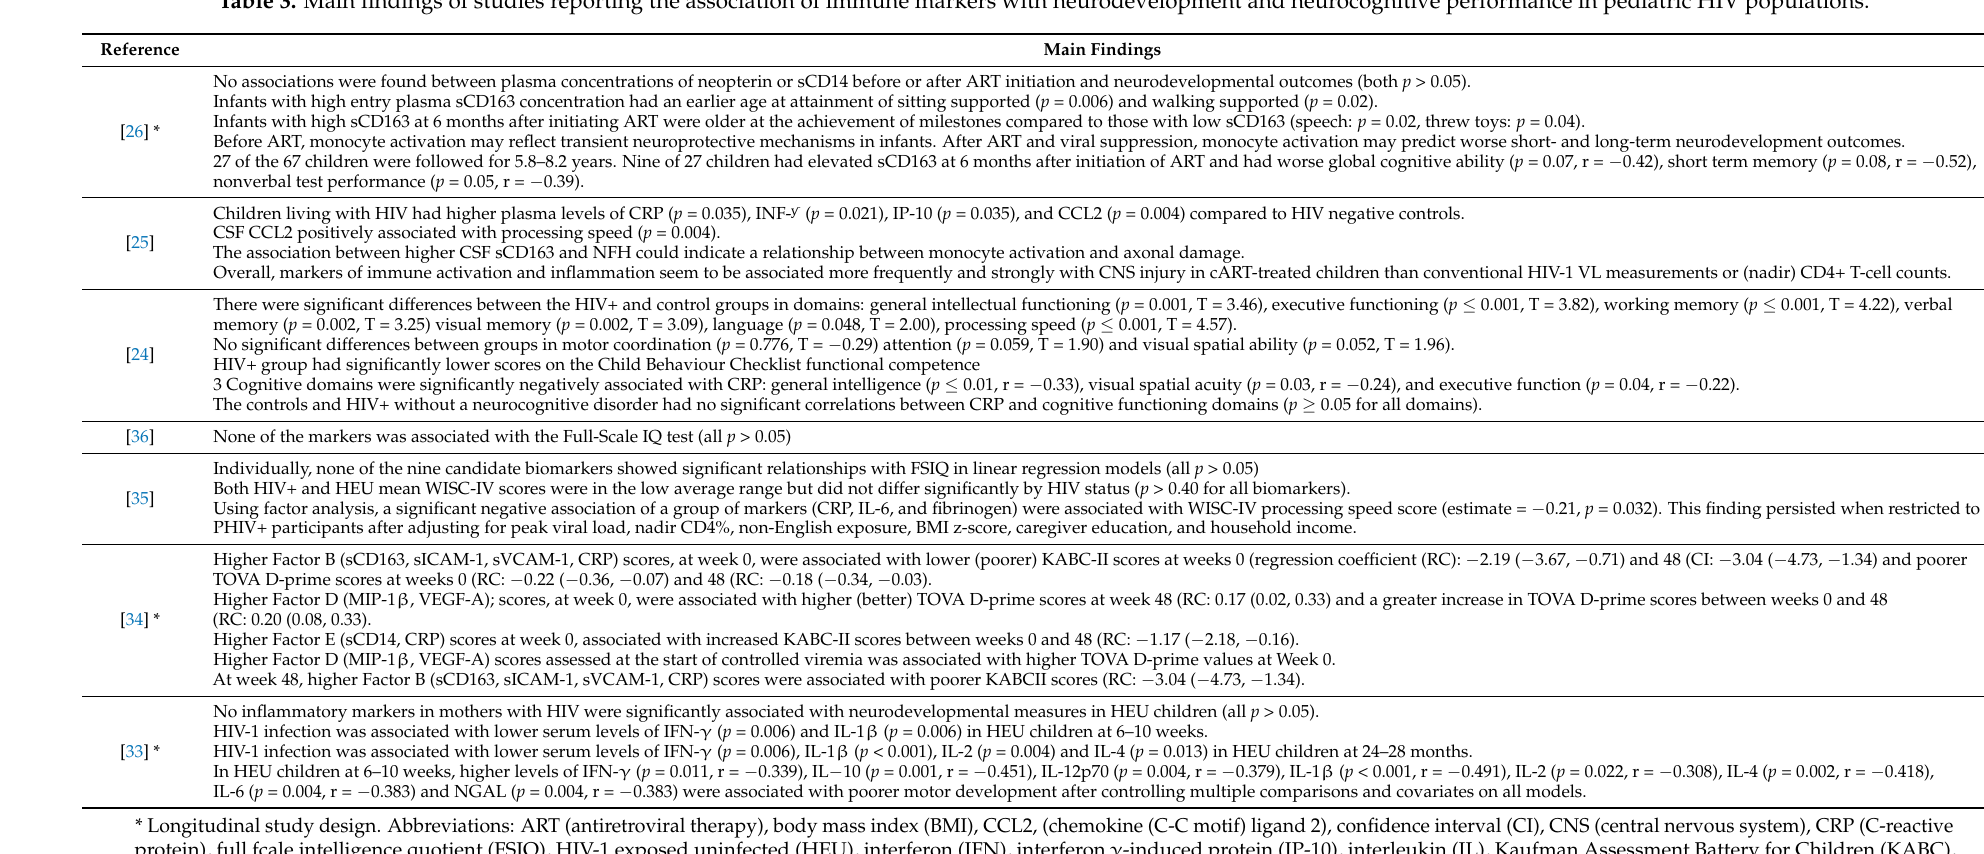
Table 3. Main findings of studies reporting the association of immune markers with neurodevelopment and neurocognitive performance in pediatric HIV populations.